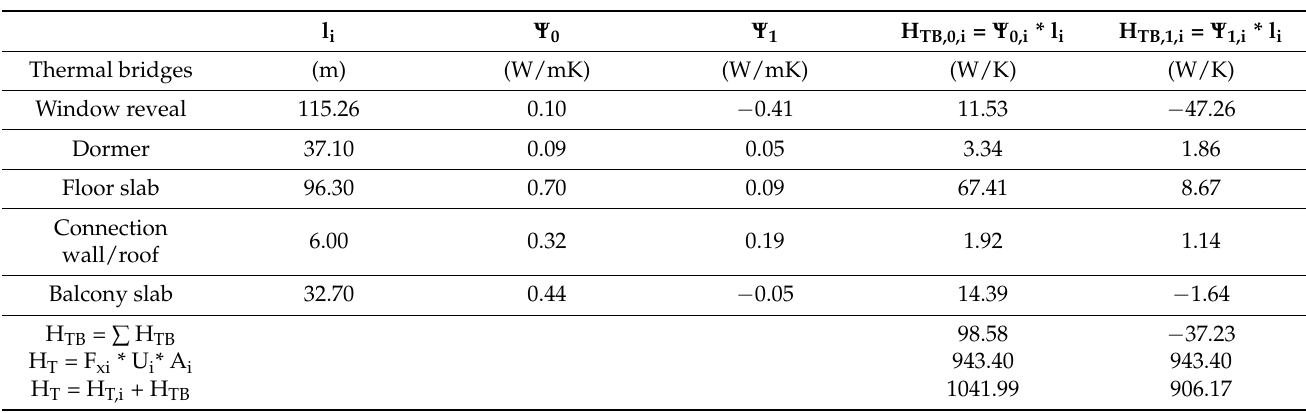
Table A34. Transmission heat losses caused by thermal bridges and total transmission heat losses of the reference building before and after a retrofit